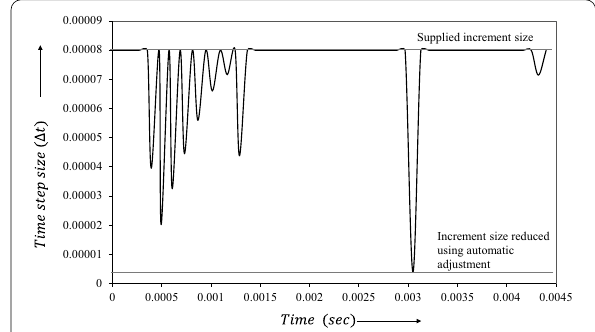
Fig. 30 History of time-step size for LCP continuous mass